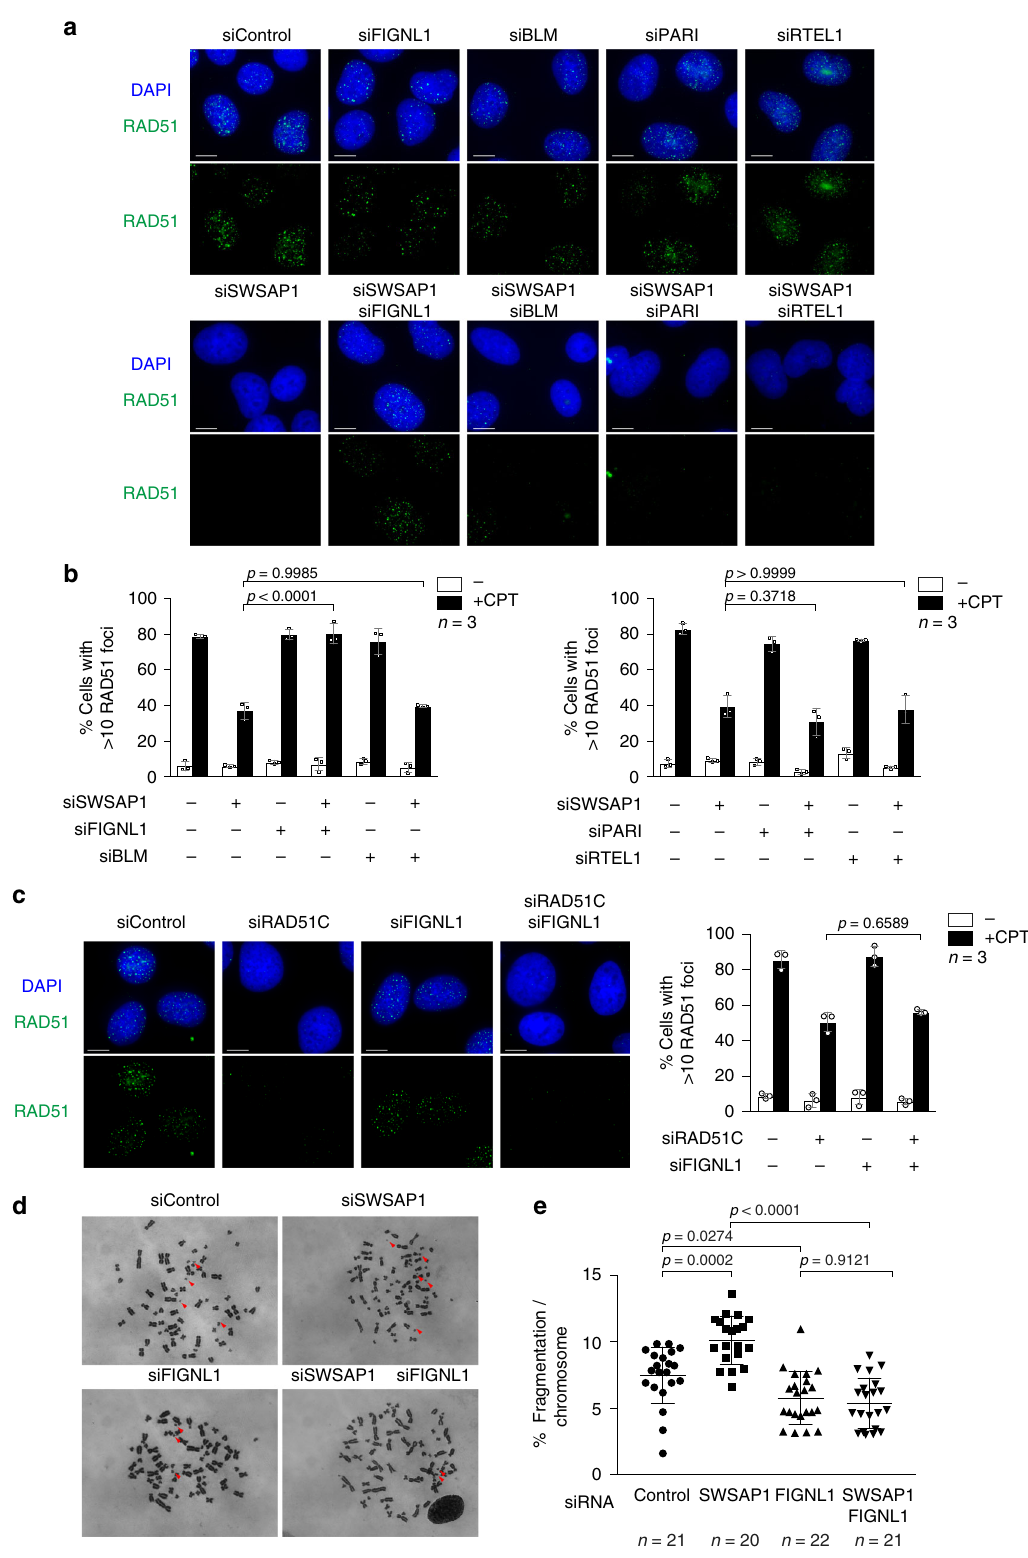
43.3 in its control; Fig. 5g). These results are consistent with the recent observation 33 . We observed relatively normal γ H2AX- staining in Swsap1 − / − leptotene cells (Supplementary Fig. 4e). These observations suggest that reduced RAD51- and